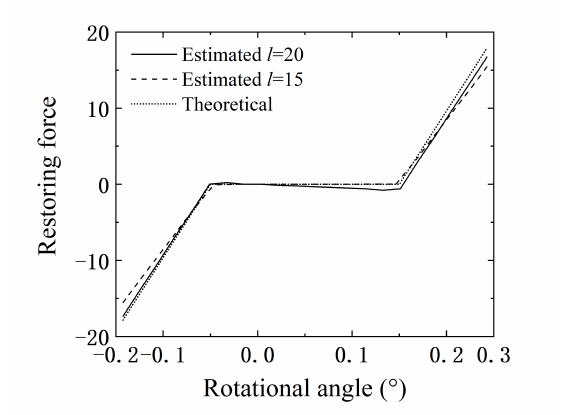
Figure 14. The nonlinear restoring force of offset freeplay under different divisions.